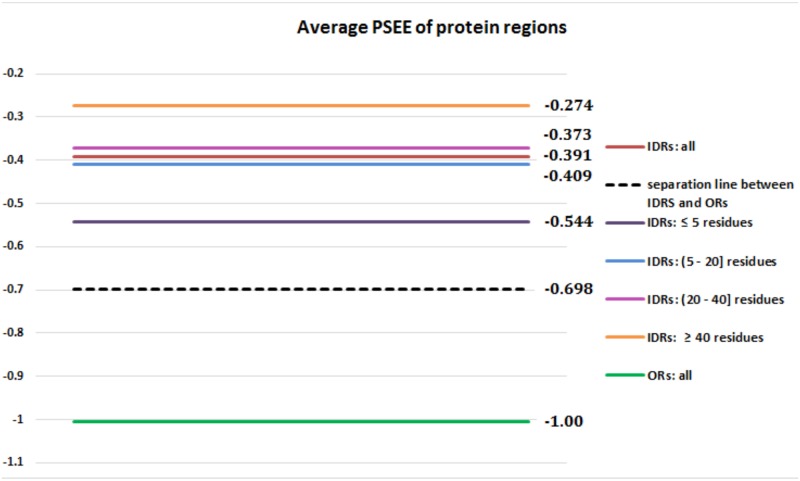
PSEE of different length disordered regions and all ordered regions.Average PSEE of different protein regions of DisProt680 dataset; ORs (green), IDRs (red) IDRs with ≥ 40 residues (orange), IDRs with (20–40] residues (pink), IDRs with (5–20] residues (blue), IDRs with leq 5 residues (purple) and the separation line between all IDRs and ORs is shown by black dashed line. The lines are labeled by the corresponding numerical values of PSEE.